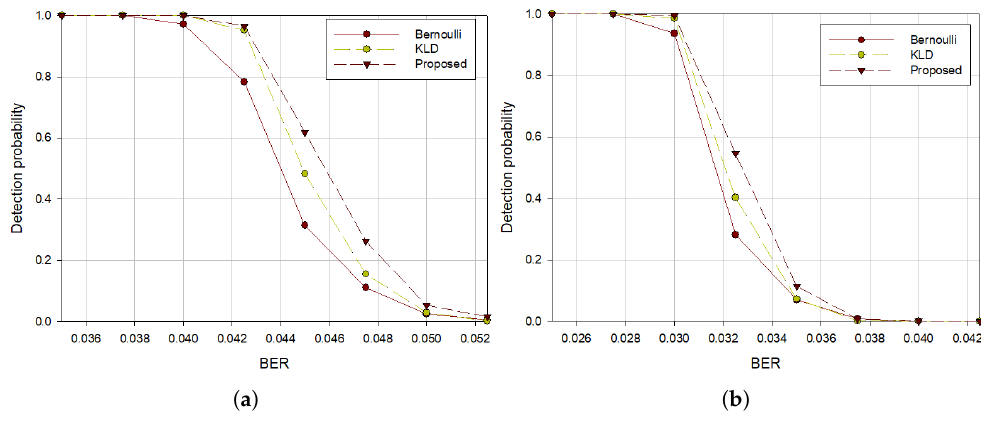
Figure 6. Detection probability with Hamming (7, 4) code when ( a ) S = 28, ( b ) S =